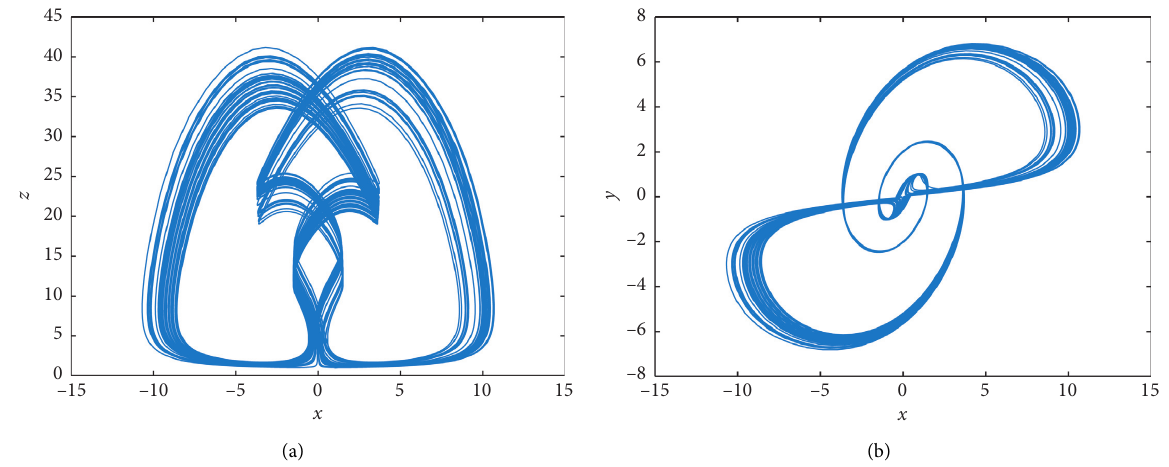
Figure 6: Phase portraits of the fractional system with α � 0 . 995.